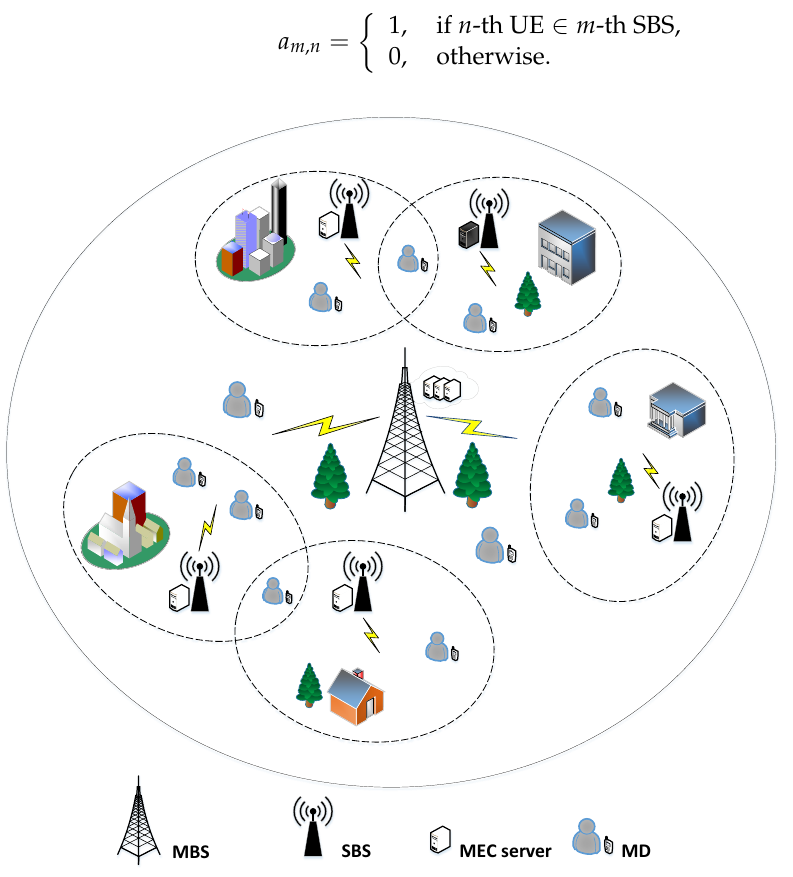
Figure 1. System model of the MEC